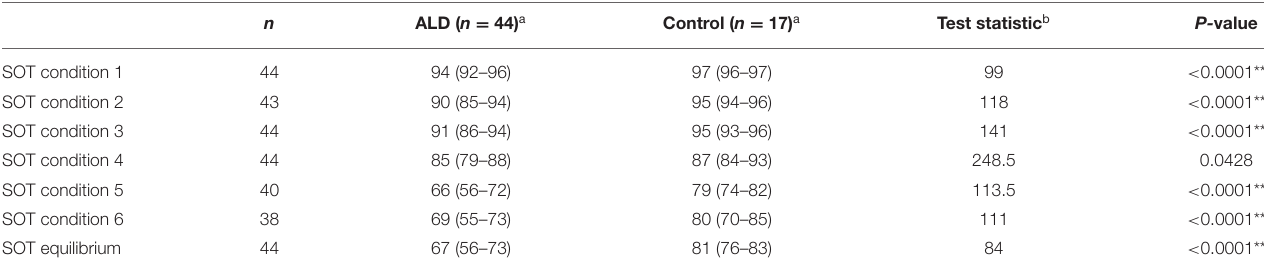
TABLE 3 | Performance on SOT for patients and